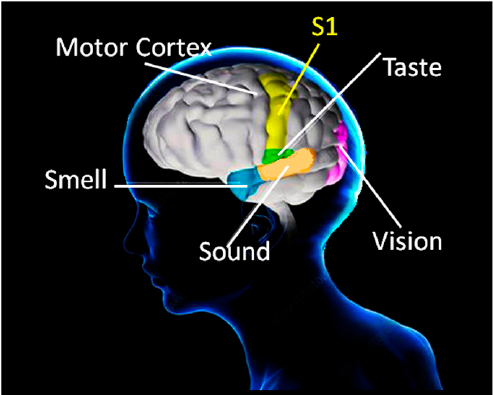
Figure 1. Anatomically adjacent to the motor cortex, the somatosensory brain (S1) controls mechanoreceptors and plays a critical role in grip-force production through functional interactions with multiple sensory areas. The prefrontal lobe controls the conscious modulation of grip forces and motor behavior (not illustrated here).